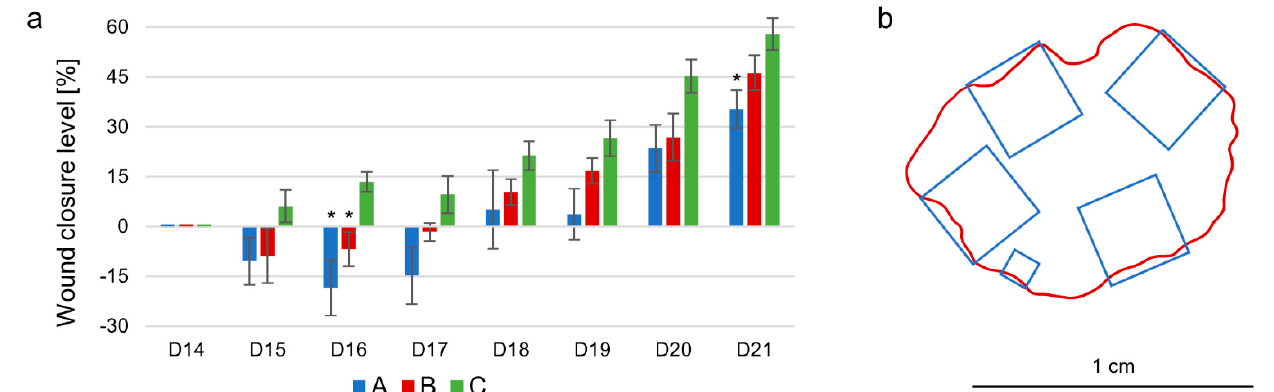
Figure 2. The wound closure level and tissue sampling. ( a ) The graph shows the wound closure level from day 14 (surgery) until day 21 (termination) in groups A (blue), B (red), and C (green), respectively. The columns represent the mean level of wound closure; the bars represent S.E.M.; * * indicates statistical significance as compared to control group. ( b ) An example of tissue sample col- lection from the wound area. From each wound, 5 tissue samples were collected from the border zone; four of them for fluorescence microscopy (3 × 3 × 3 mm), one for electron microscopy (1 × 1 × 1 mm). The bar represents 1 cm.